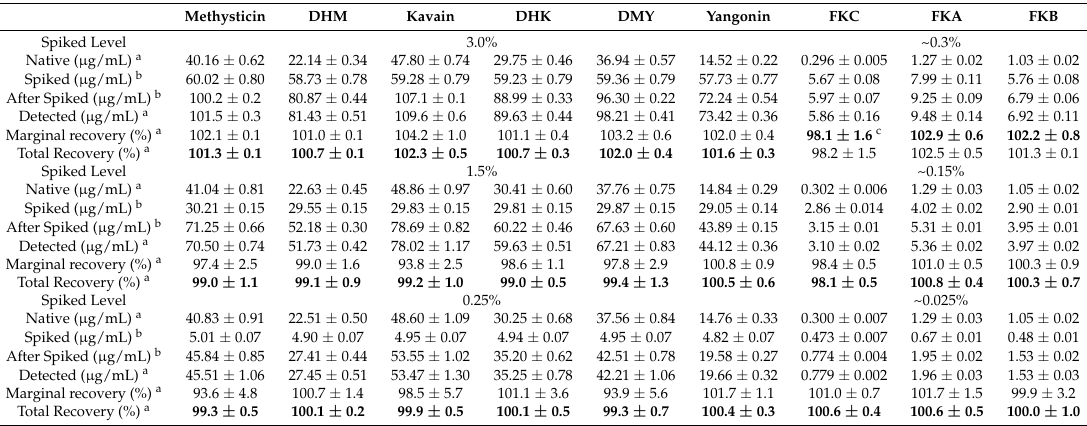
Table 4. Spike recovery results of HPLC-UV method for determination of kavalactones and flavokavains. Methysticin